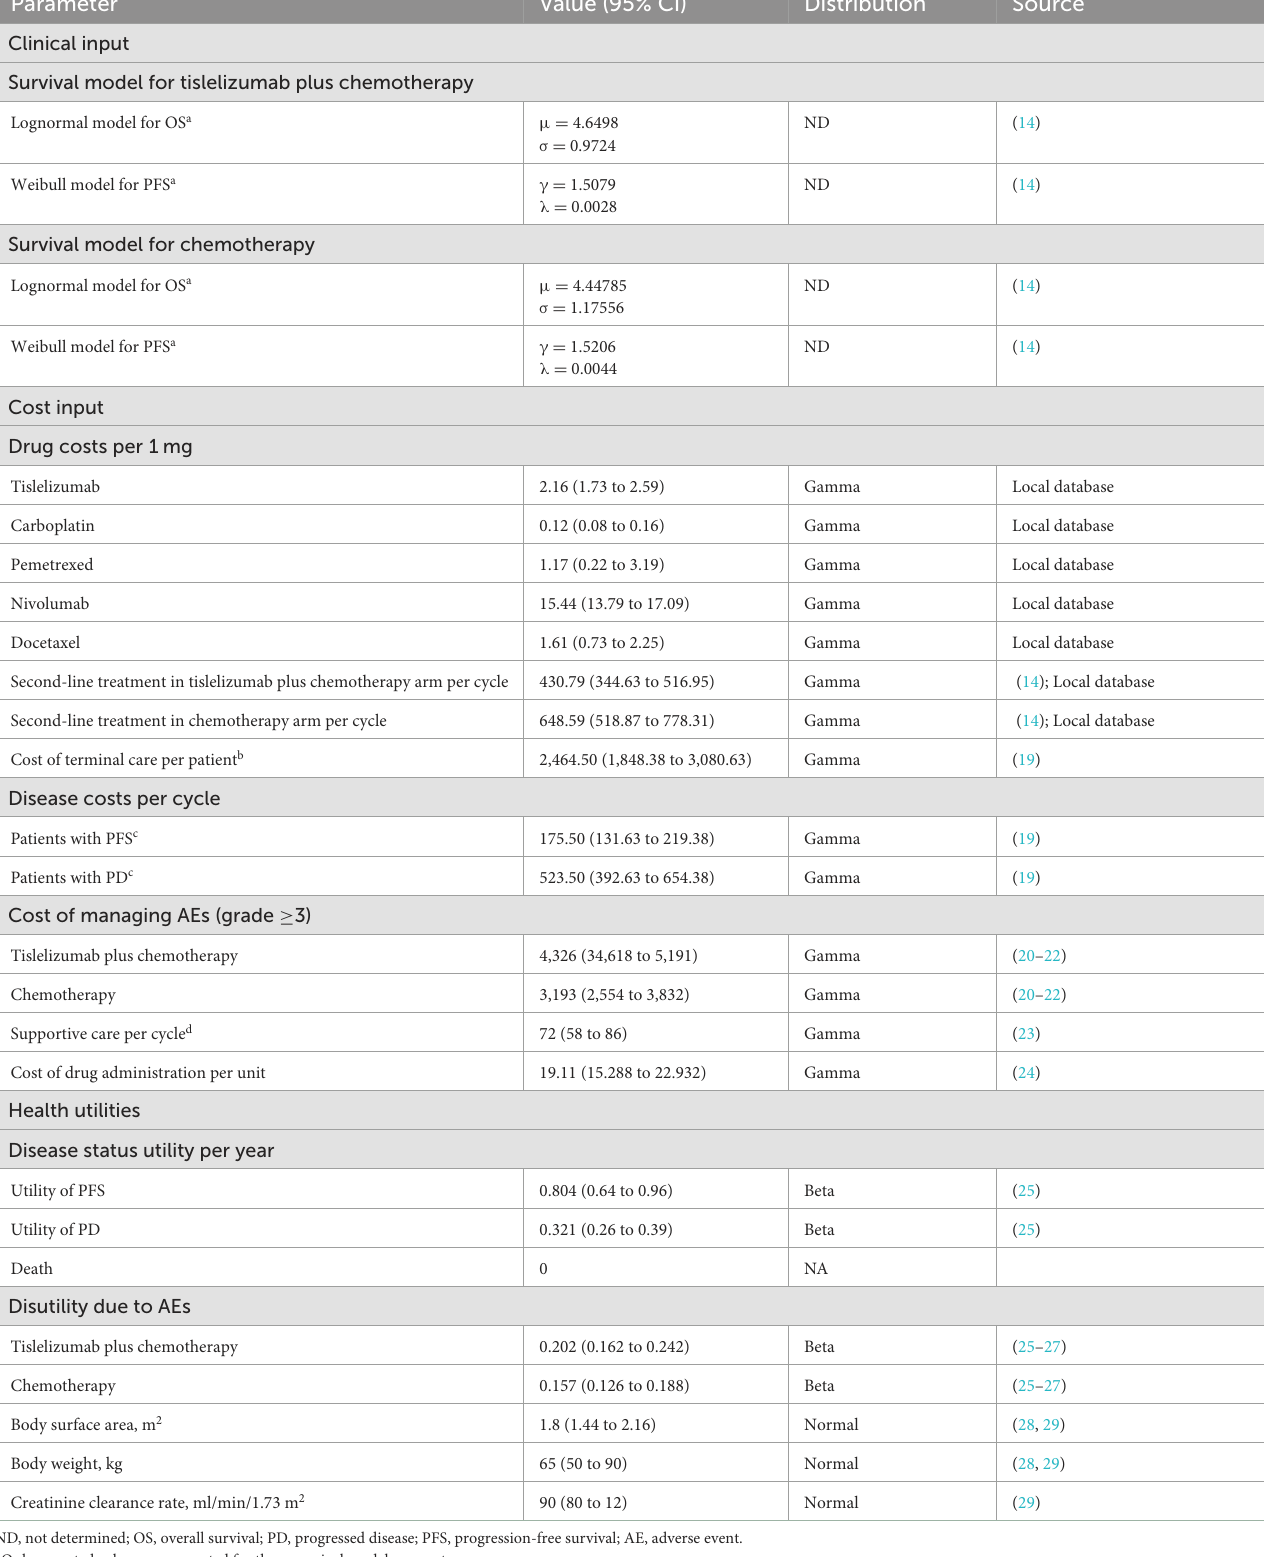
TABLE 1 Key model inputs.